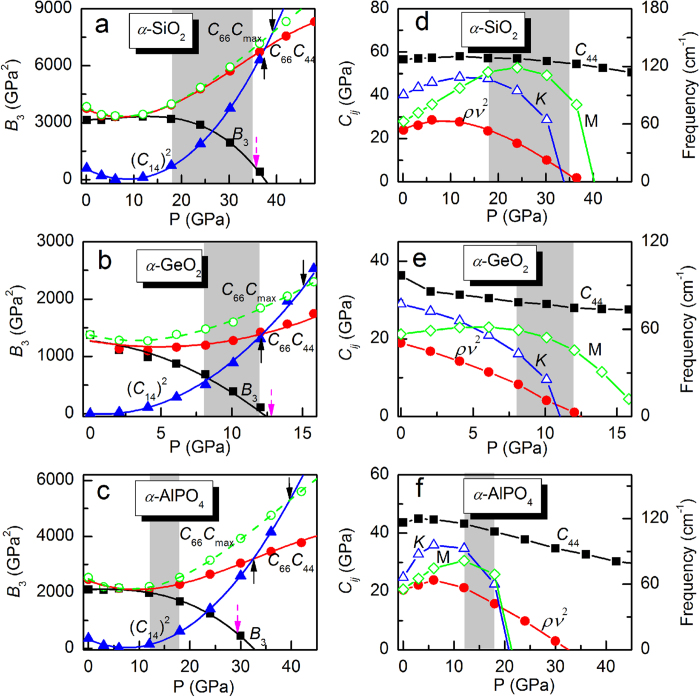
Born coefficient B3 and soft acoustic mode elastic constants.(a)–(c) Born coefficient B3 and (d)–(f) soft acoustic mode elastic constant ρν2 of α-SiO2, α-GeO2, and α-AlPO4 as a function of pressure. In (a)–(c), the respective contributions of C66C44 (solid circles) and  (solid triangles) to B3 (solid squares) are shown. The open circles are  with  being the maximum value of C44. The dashed arrows represent the pressures where C44 crosses with C14. In (d)–(f), the variation of C44 and the calculated zone-edge K- and M-point soft mode frequencies with pressure are also displayed. The gray areas indicate the amorphization boundaries determined from the experiments202436.